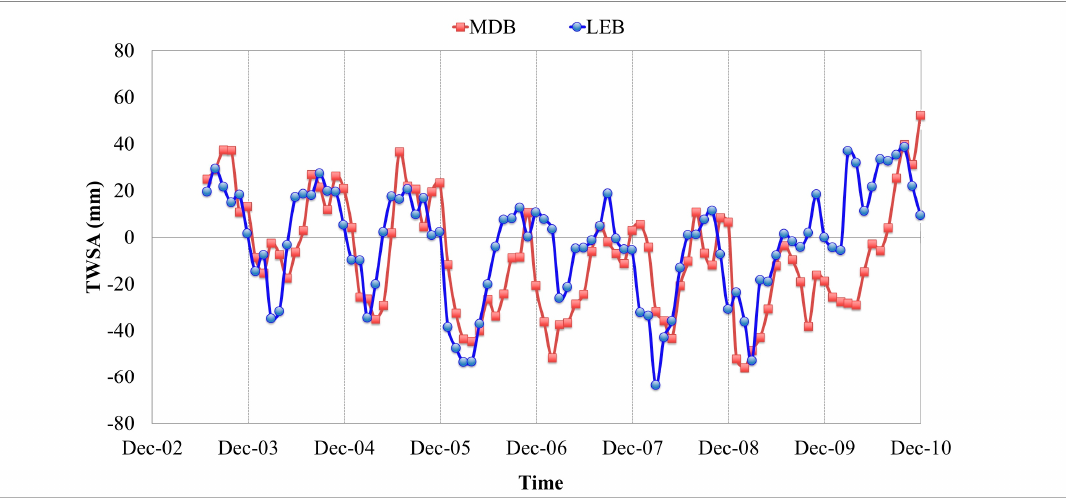
Figure 8. Time series of terrestrial water storage anomaly (TWSA) between 2003 and 2010 from GRACE regional solutions over the MDB (red) and the LEB (blue). Table 3. Annual changes in terrestrial water storage ( ∆ S ) over the MDB and the LEB between 2003 and 2010. Annual ∆ S was computed as the TWS difference between the end month (August) and the start month (July) within a hydrological year (unit: mm/year).